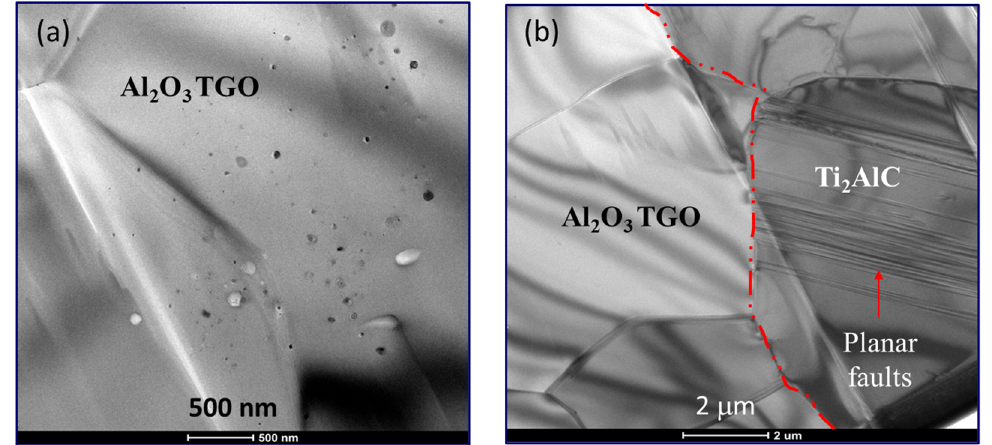
Figure 4. Features in Al 2 O 3 TGO (I): ( a ) Fine 50 nm, dispersed intragranular porosity (light) and particles (dark) in Al 2 O 3 grains near TBC; ( b ) clean, intact Al 2 O 3 /Ti 2 AlC interface (dashed red line) and ~20 closely spaced, highly aligned linear faults in the Ti 2 AlC grain.